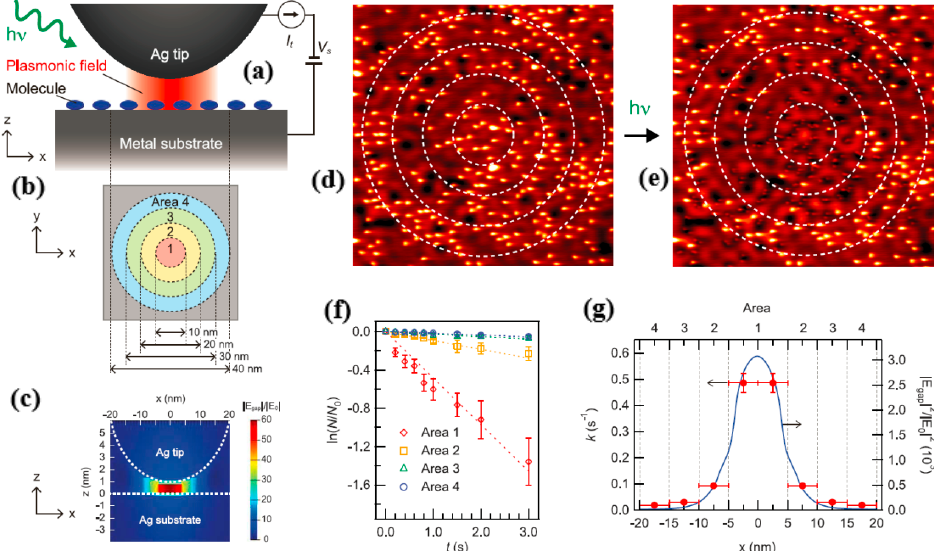
Figure 13. Real-space investigations of the plasmon-induced chemical reaction. ( a ) Schematic illustration of the experiment for the real-space investigation of the plasmon-induced chemical reaction in the nanogap between an Ag tip and a metal substrate. The tip was positioned over the metal surface during light irradiation with the feedback loop turned on to maintain the gap distance. The V s and I t were kept at 20 mV and 0.2 nA. h ν , Planck’s constant ( h ) multiplied by frequency ( ν ). ( b ) Division of the scanning tunneling microscope (STM) image into four areas depicted with 10-nm wide concentric rings for analysis. ( c ) Simulated spatial distribution of the electric field at the 1-nm gap under p-polarized light at 532 nm. E 0 was the incident electric field. Topographic STM images of ( CH 3 S ) molecules on Ag(111) ( d ) before and ( e ) after irradiation with p-polarized light at 532 nm (~7.6 × 10 17 photons cm − 2 s − 1 , 2 s) (V s = 20 mV, I t = 0.2 nA, 43 nm by 43 nm). The tip was positioned at the center of area one during light irradiation. ( f ) Time dependence of the dissociation ratio ( N / N 0 ) under irradiation with p-polarized light at 532 nm (~5.9 × 10 16 photons cm − 2 s − 1 ) in the four areas shown in ( b ). Each data point represents the average of results from six trials. The dotted lines denote single exponential functions fitted to the data points [ ln ( N / N 0 ) = − kt ] . Error bars indicate SD. ( g ) The rate constant k obtained at areas one through four and the calculated lateral profile of electric field intensity at 0.1 nm above the substrate surface (z = 0.1 nm) under 533-nm light. x = 0 nm corresponds to the center of the tip. Adapted from [13].